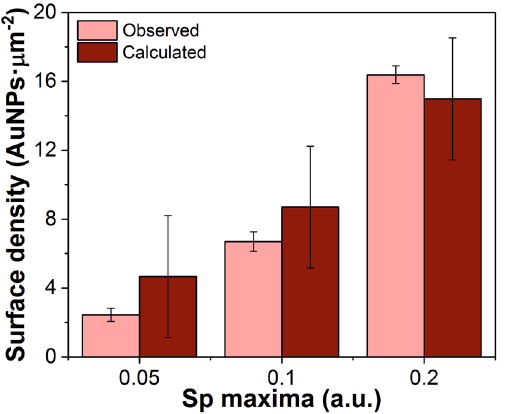
Figure 4. AuNPs density of probes with different initial Sp maximum values. Observed and calculated AuNPs surface density of fibers fabricated with three different Sp maximum values: 0.05, 0.10 or 0.20 a.u. (n =